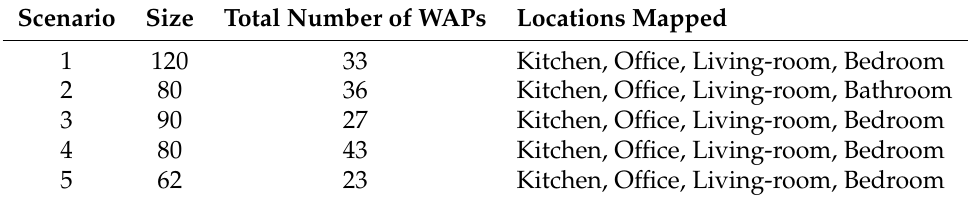
Table 2. Scenario characteristics, the size for each flat is given in squared meter. The total number of WAPs states for the total number of WAPs present in all samples acquired in the experiments for each scenario.